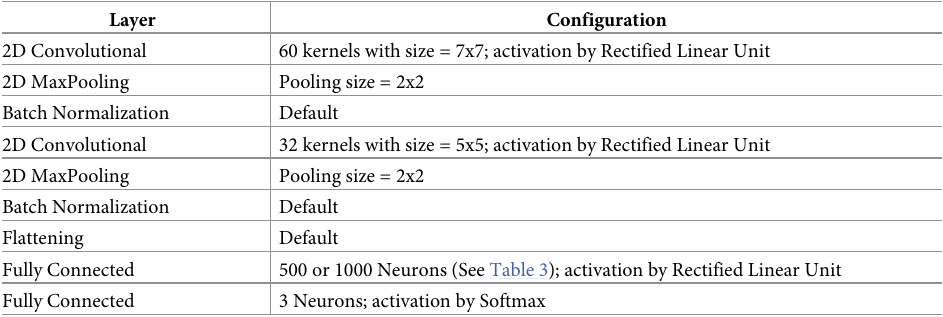
Table 2. Model architecture based on the convolutional neural network that was used to classify the pain level for each evaluated parameter (ears, eye and mouth and nostrils). Layer